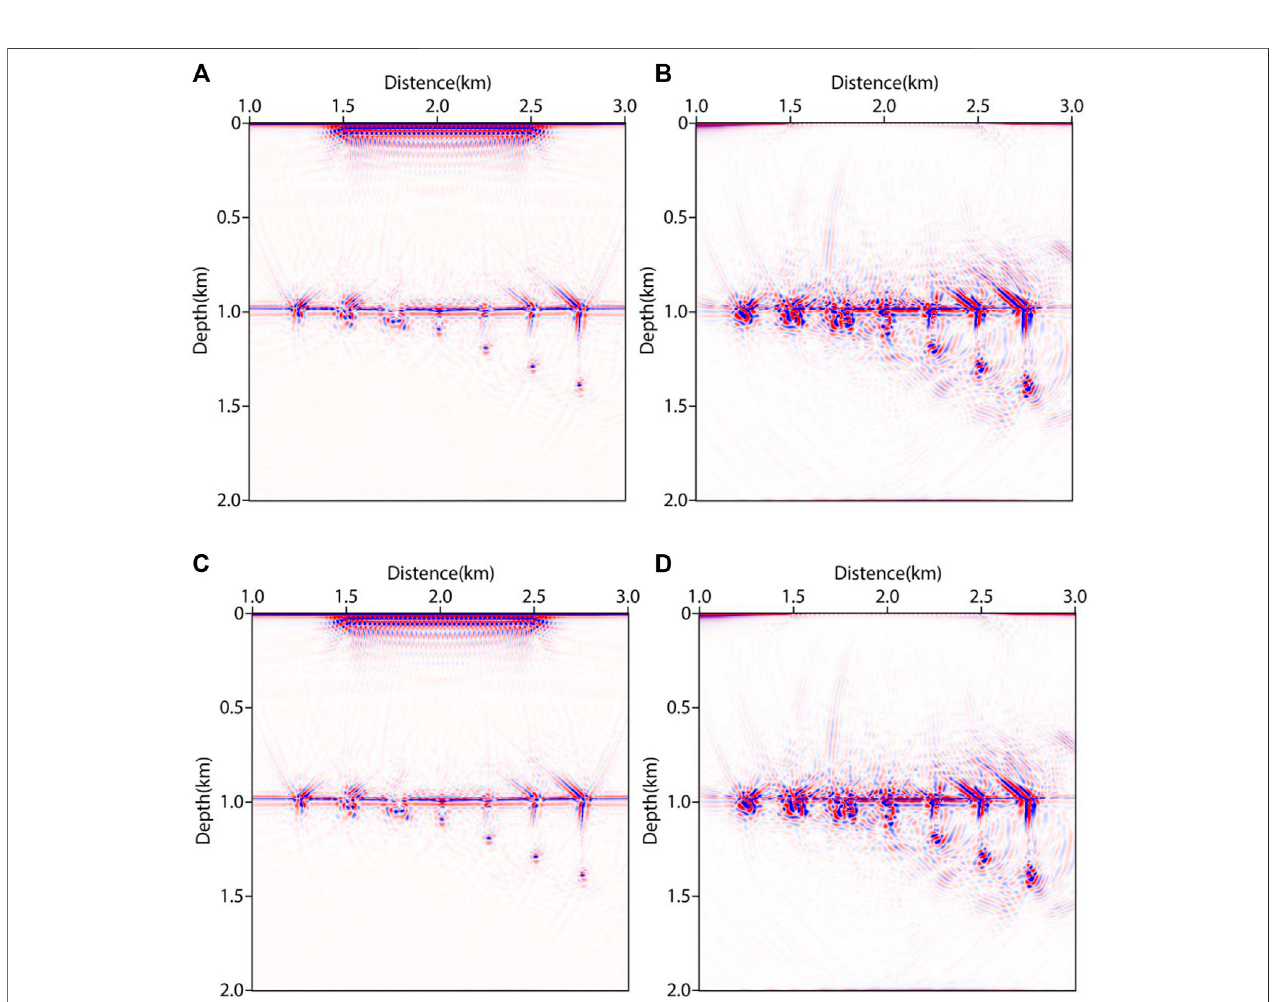
FIGURE 12 | Migration images using different methods after 30 iterations. (A) F-LSRTM, (B) D-LSRTM, (C) AS-F-LSRTM with linear interpolation, and (D) AS-D- LSRTM with linear interpolation.